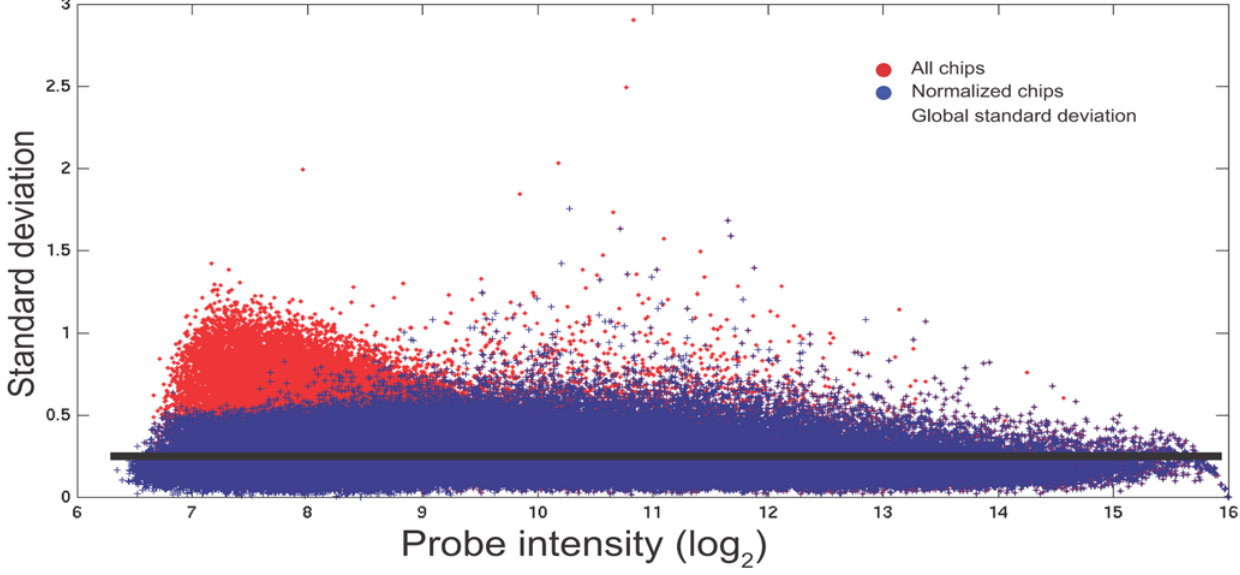
Figure 2. Standard deviation versus intensity for all probe sets. Plotting standard deviation versus intensity for all probes across the 5 arrays (red circles) allowed a mean level of interest to be calculated for the standard deviation. This was considered as a global measure of the standard deviation ( s g ) between probes in the set of 5 arrays. All extreme outliers were removed (see text for details) and the result from this filtering is shown by blue circles.